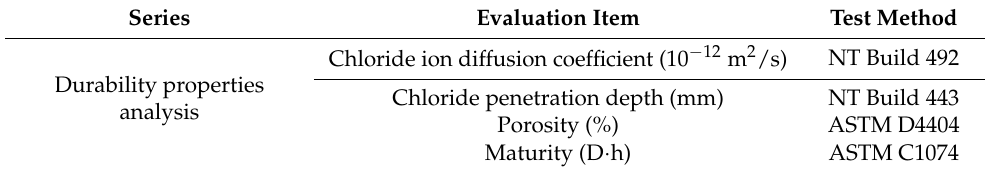
Table 6. Test methods for engineering and durability properties of